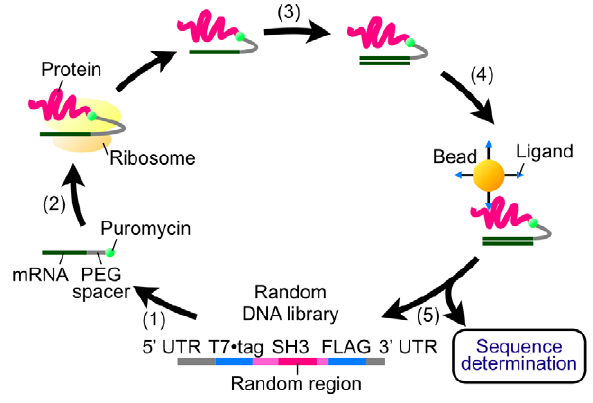
Figure 3. Schematic representation of mRNA-display selection of functional SH3 sequences. (1) A DNA library encoding a randomized SH3 domain with an N-terminal T7 ? tag and a C-terminal FLAG tag was transcribed and ligated with a PEG-puromycin spacer. (2) The modified mRNA library was translated in vitro , and (3) the resulting mRNA-protein conjugates were purified with anti-FLAG antibody- immobilized beads and reverse-transcribed. (4) The mRNA/DNA-protein conjugates were incubated with the ligand peptide-immobilized beads, washed and competitively eluted with the free ligand peptides. (5) The DNA portion of the eluted molecules was amplified by PCR to form a randomized DNA library for the next round.